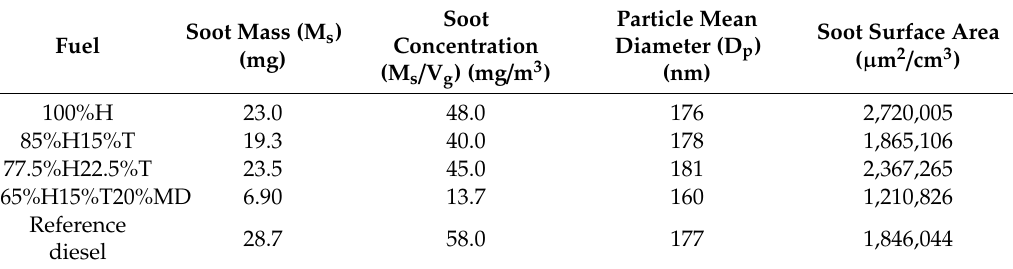
Table 5. Filter soot mass measurements without 2-EHN ignition improver.